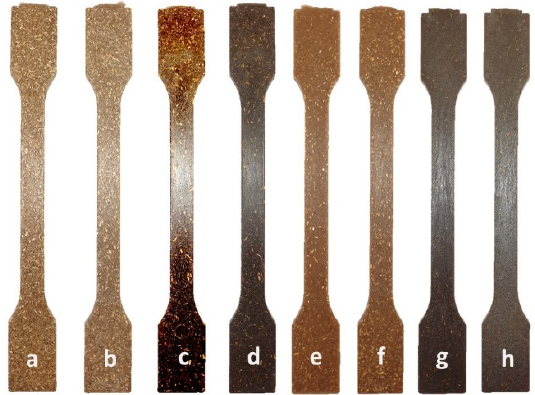
Figure 4. Test specimens of composites and biocomposites with halophyte biomass: ( a ) PP/Hemp20, ( b ) PP/Hemp30, ( c ) PP/Grass20, ( d ) PP/Grass30, ( e ) PLA/Hemp20, ( f ) PLA/Hemp30, ( g ) PLA/Grass20, ( h ) PLA/Grass30.